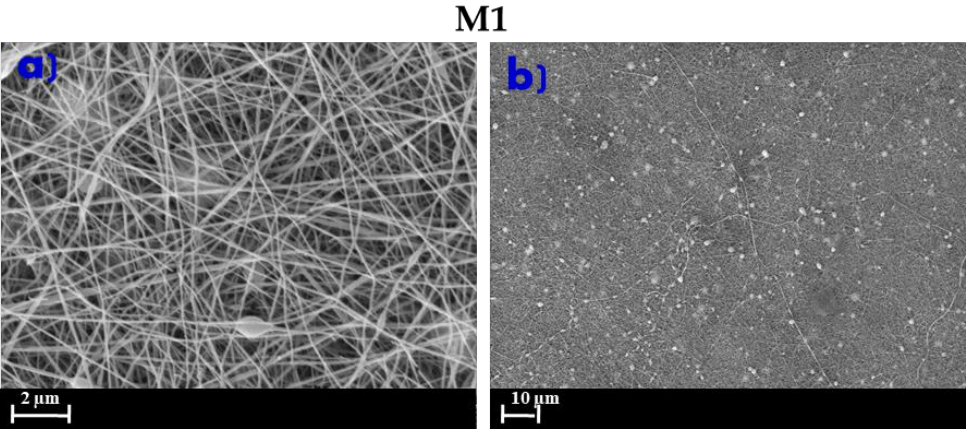
Figure 4. SEM pictures of ENMs prepared using N,N- dimethylformamide (DMF) / acetone as a mixture of solvents. ( a ) M1 2 µ m; ( b ) M1 10 µ m. Conditions of electrospinning process: 15 kV voltage and 15 cm of needle to collector